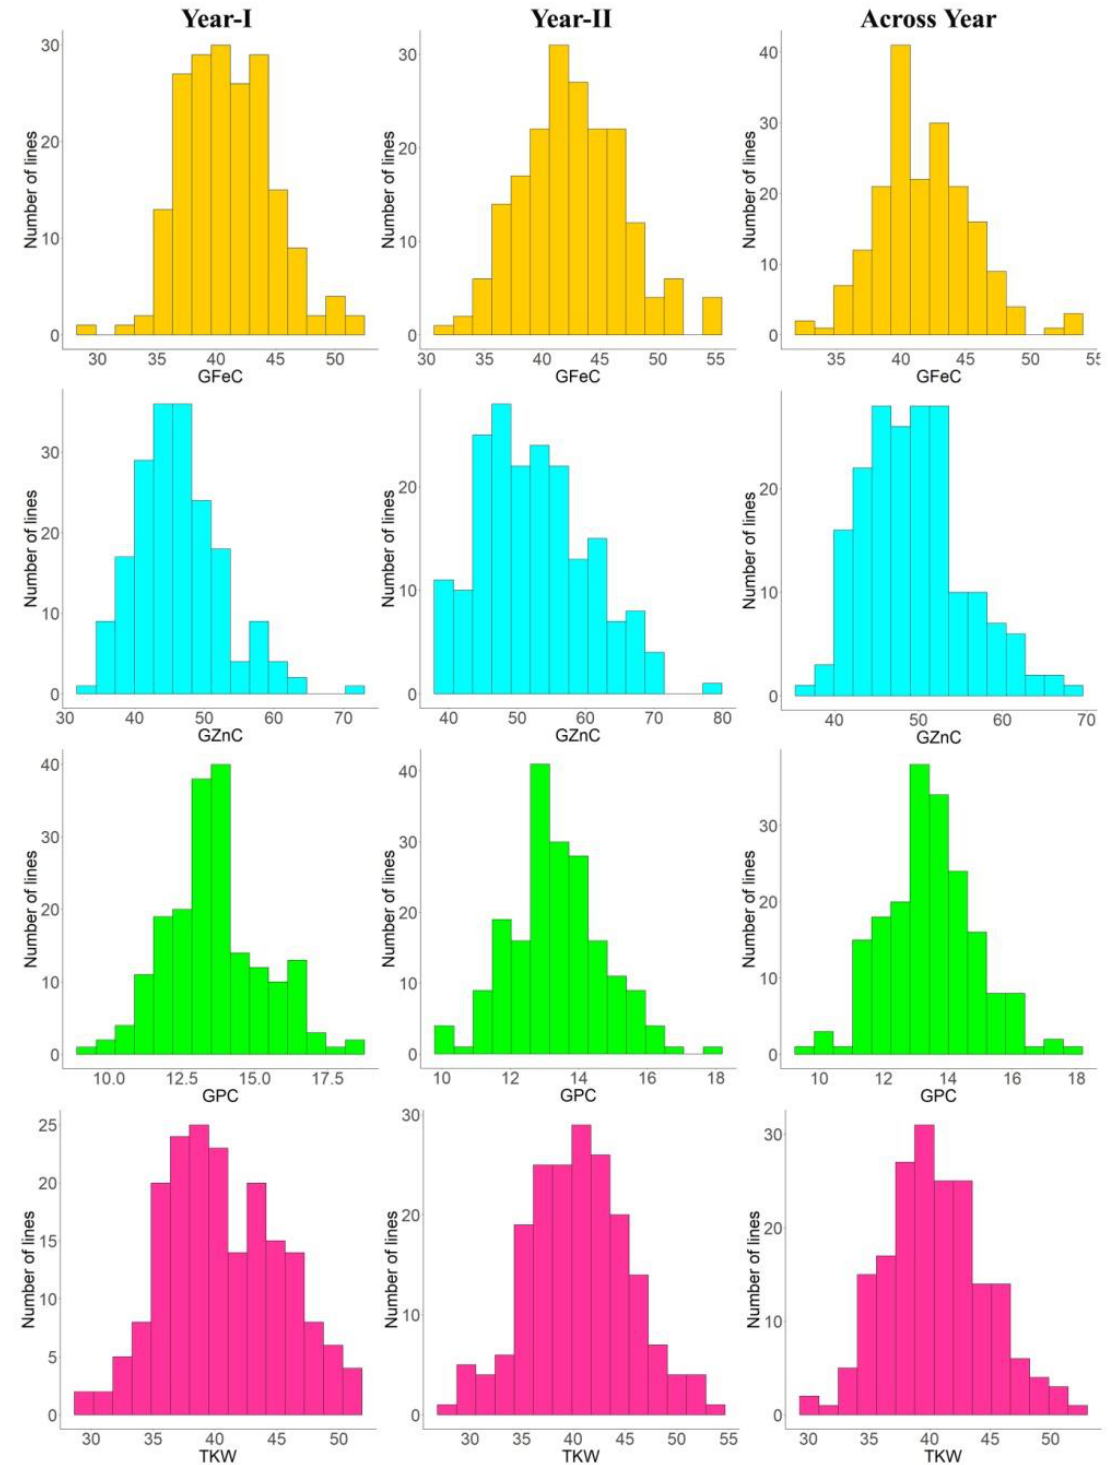
Figure 2. Frequency distributions for GFeC, GZnC, GPC, and TKW in the RIL population grown at ICAR-IARI during 2017 – 18 (year I) and 2018 – 2019 (year II) and across years.